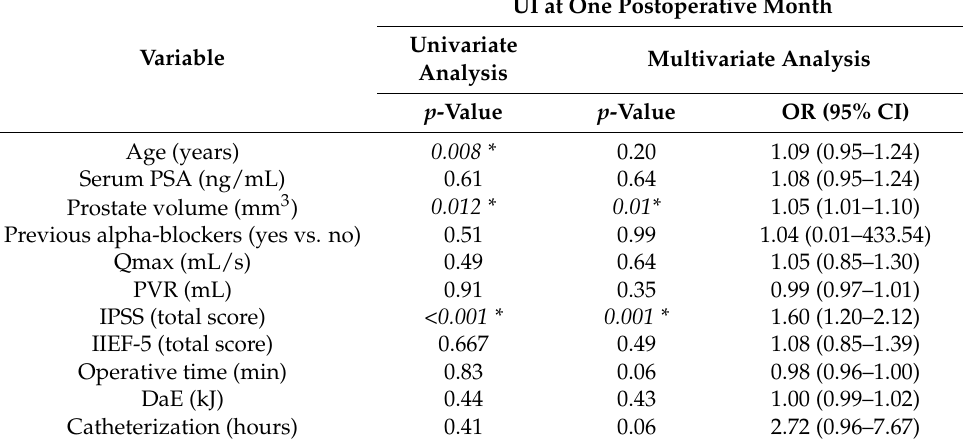
Table 5. Univariate and multivariate analyses (logistic regression) predicting UI at one month with preoperative